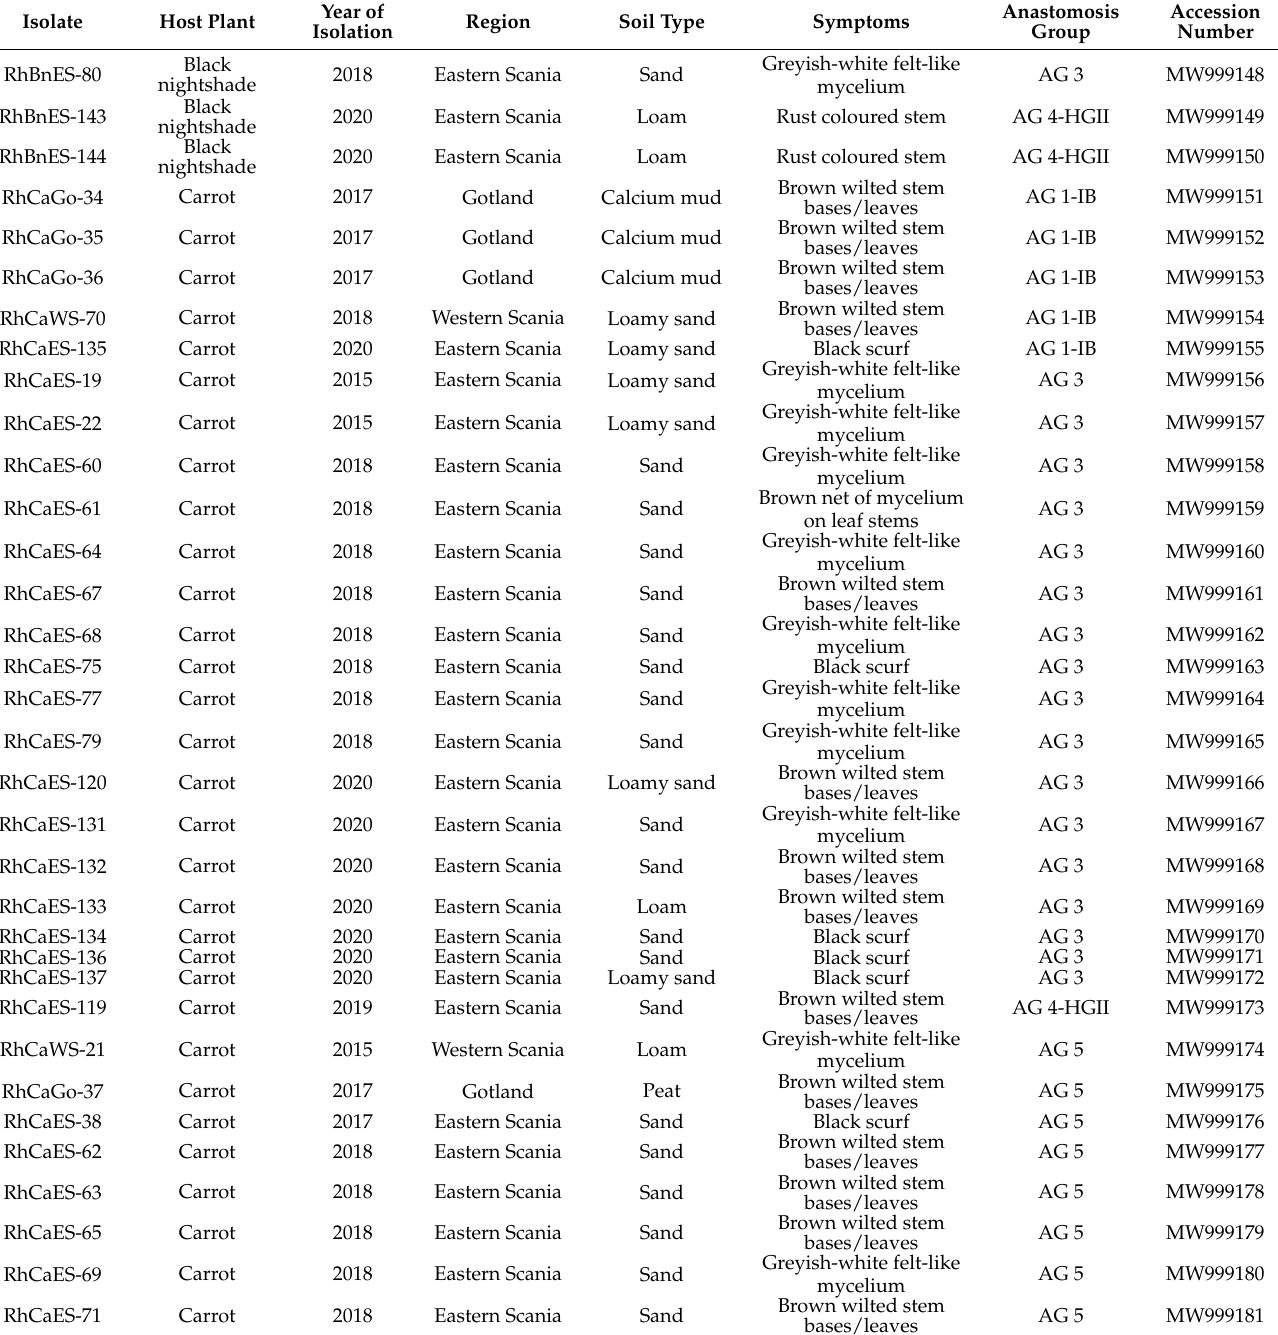
Table 1. Origin and identification of Rhizoctonia isolates obtained from black nightshade (Bn), carrot (Ca) and potato (Po) in different regions of Sweden 1